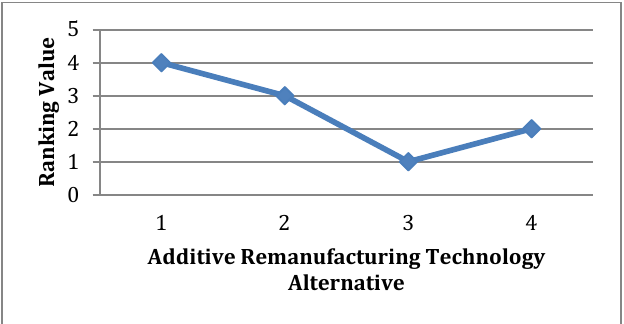
Figure 26: Ranks of additive remanufacturing portfolio alternatives